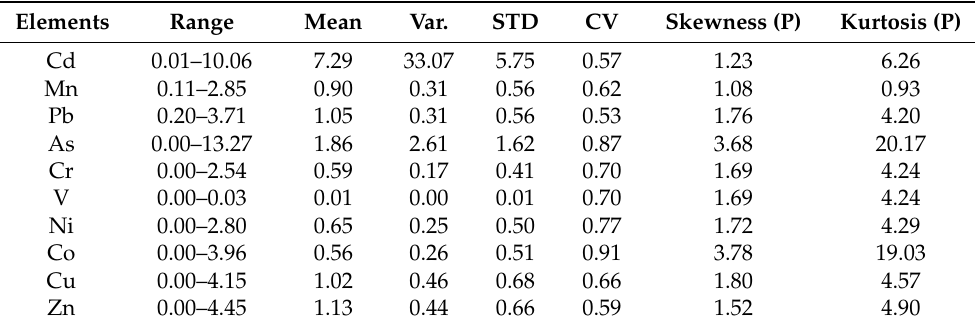
Table 6. Descriptive statistics of pollution index (PI) values.